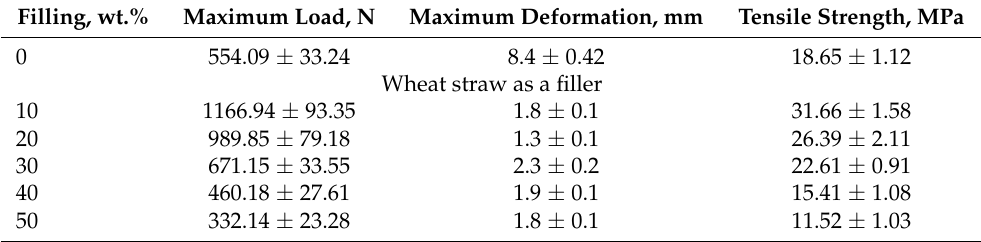
Table 3. Results of bending tests of